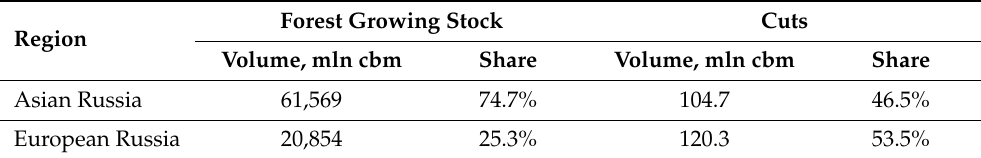
Table 2. The forest growing stock and cuts in Asian and European parts of Russia. Forest Growing Stock Cuts Region Volume, mln